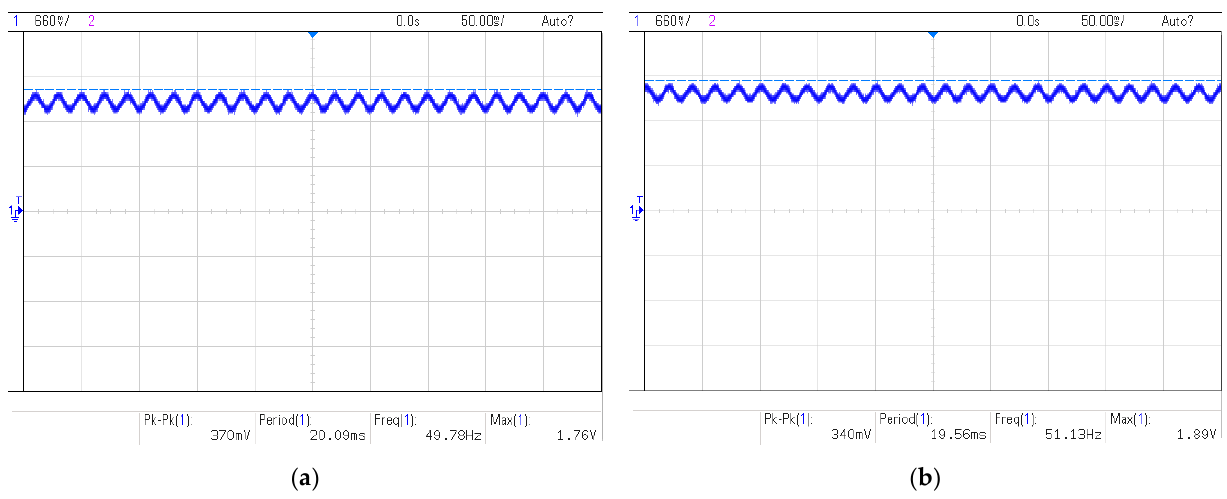
Figure 25. Experimental results showing ACS722 current sensor outputs: ( a ) The current output of phase “A”, ( b ) The current output of phase “B”.